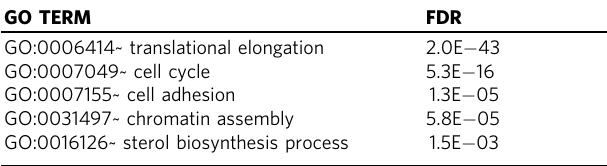
Table 1 Five chosen GO terms from DAVID on differentially expressed genes in UBR7-knockdown MCF10A cells (FDR <0.01; FC